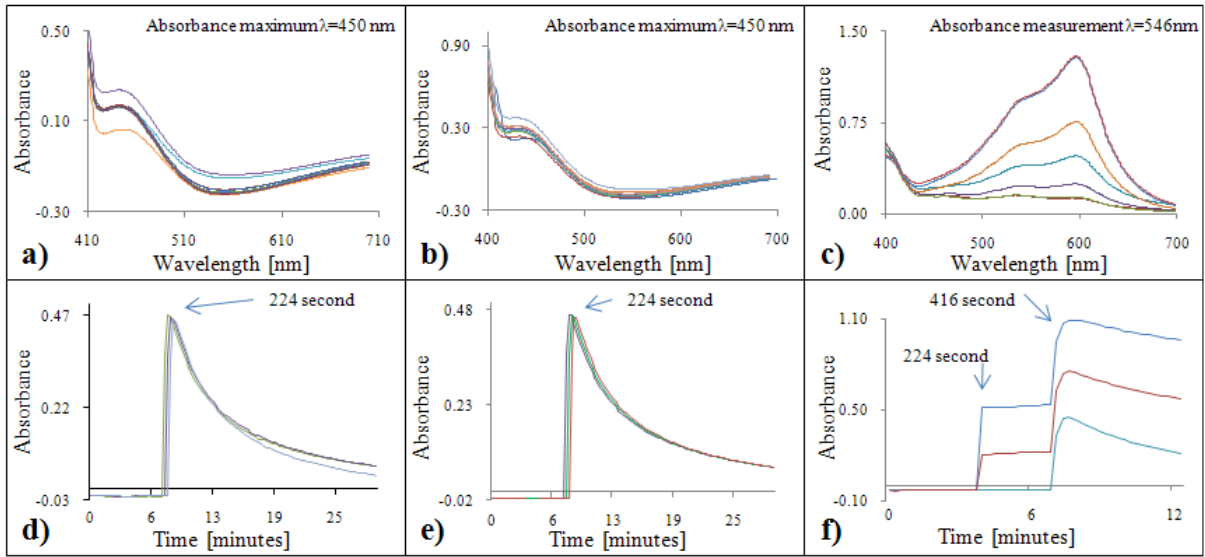
Figure 6. Blue CrO absorption spectra (450 – 700 nm) for gallic acid (a) , Trolox ® (b) and 5 δ tocopherol (c) . Dependence of absorbance of Blue CrO and δ tocopherol (c) on